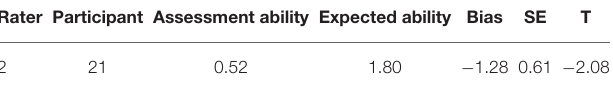
TABLE 7 | Bias analysis of raters and